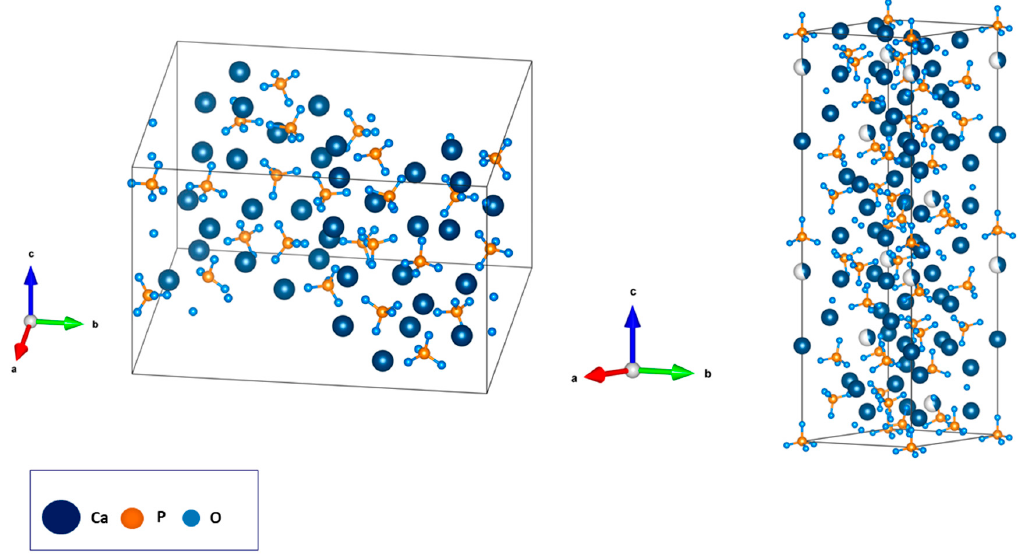
Figure 2. The crystalline structures of tricalcium phosphate (TCP): α form ( left ) and β form ( right ).